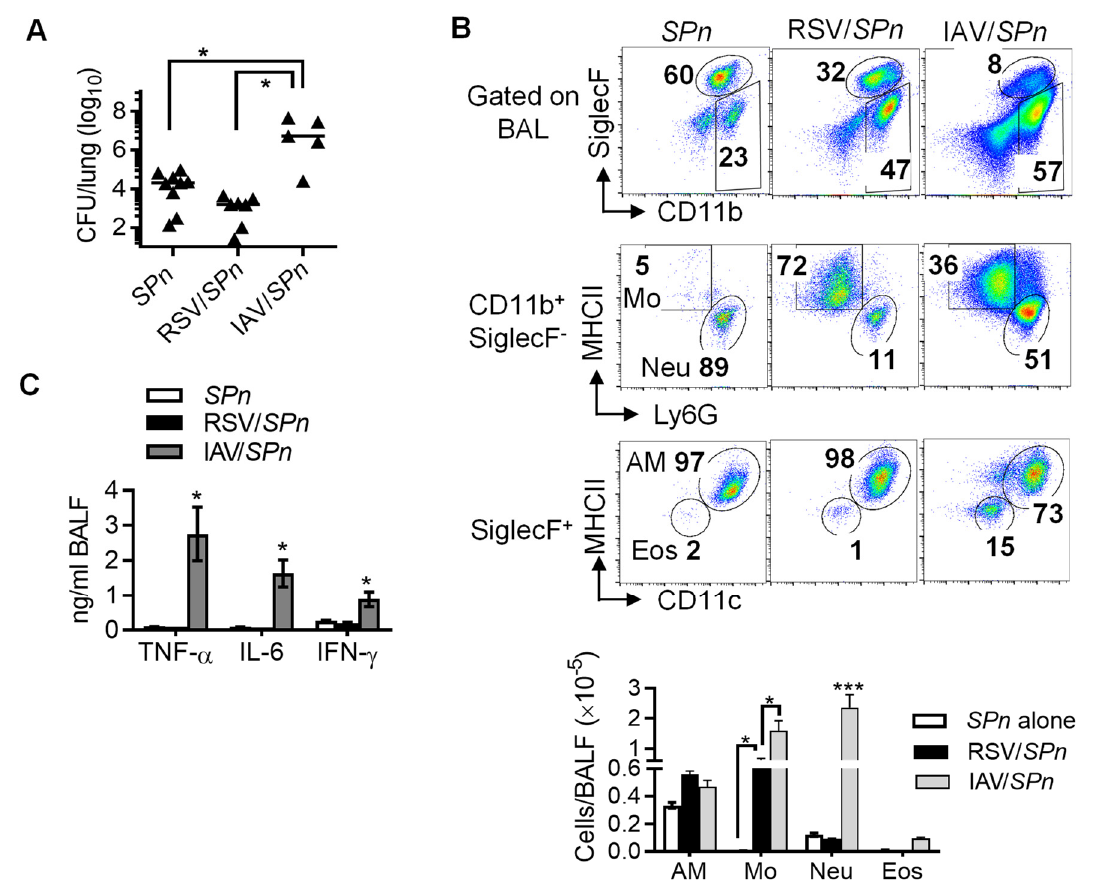
Figure 1. Prior RSV infection has no significant impact on acute bacterial clearance during secondary S. pneumoniae infection. C57BL/6 WT mice were infected with RSV or X31 (IAV) and 7 days later super ‐ challenged with SPn . ( A ) Lung SPn burdens, ( B ) Representative dot plots (top panel) and numbers (bottom panel, mean ± SE, n ≥ 5) of airway alveolar macrophages (AM), monocytes (Mo), neutrophils (Neu), and eosinophils (Eos), and ( C ) levels of TNF ‐α , IL ‐ 6, and IFN ‐γ (mean ± SE, n ≥ 5) at 24 h after SPn infection. Each dot represents one mouse; * p < 0.05, *** p < 0.001, one ‐ way ANOVA with Tukey’s multiple comparisons’ test. Data shown are representative of two independ ‐ ent experiments.